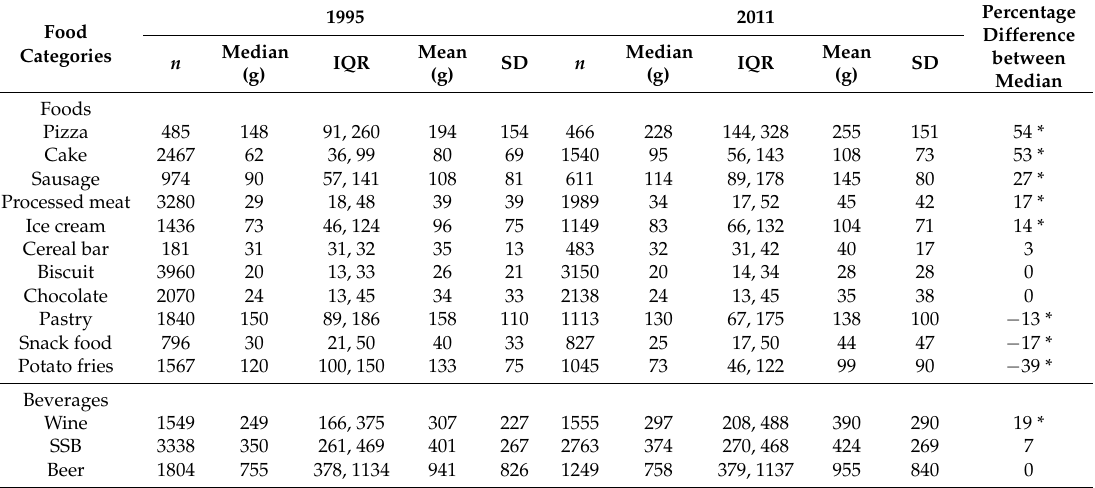
Table 2. Comparison of typical portion sizes (in grams) of discretionary foods between 1995 and 2011–2012.